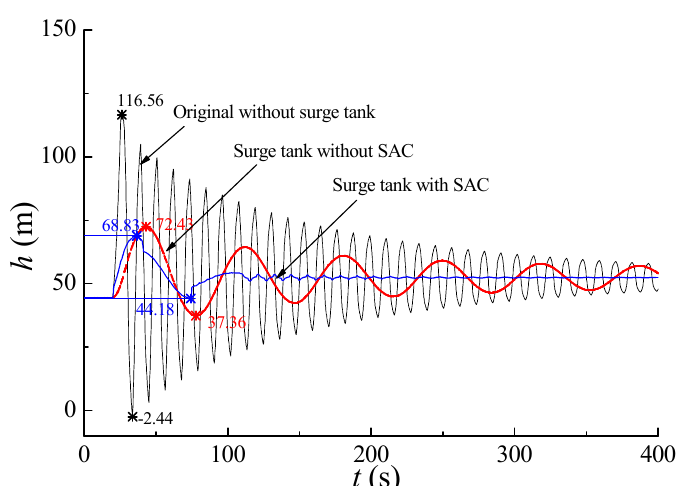
Figure 12. Comparison of the pressure fluctuation process of pipeline control points.